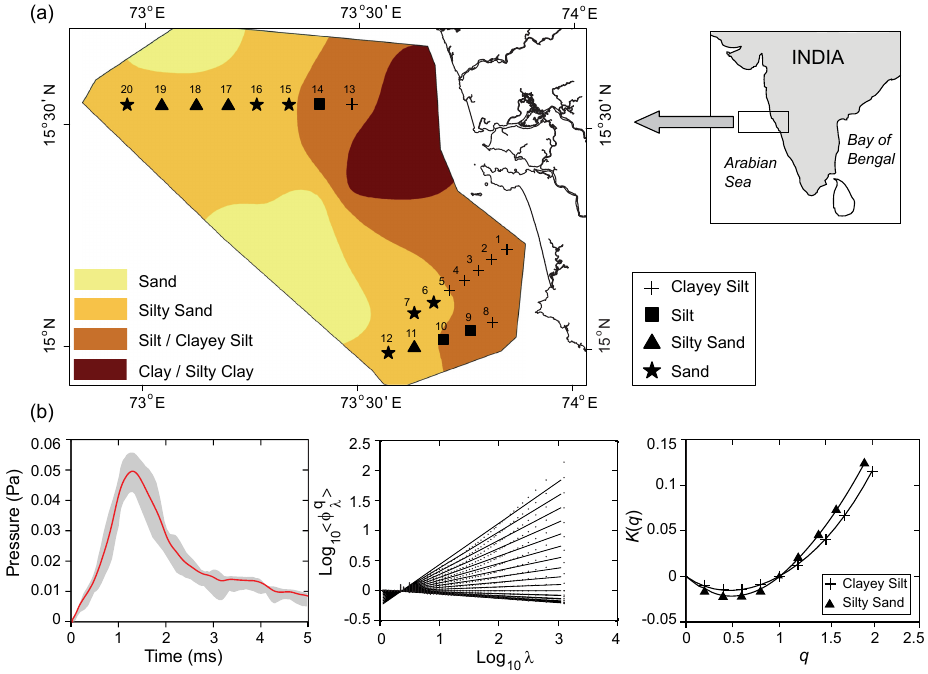
Fig. 1. (a) GIS-based sediment distribution map of the study area showing the acoustic and sediment data acquisition locations. The acoustic data were sampled with RESON-NS 420 dual-frequency SBES along the three tracks. The ground truth sediment information was collected using a Van Veen grab. Panel (b) represents the graphical abstract of the methodology implemented in the study. The dual-frequency echo envelopes (red curve) from 20 locations are subject to stochastic-based universal multifractal analyses to verify the existence of multiscaling. The shaded region represents the variability of the